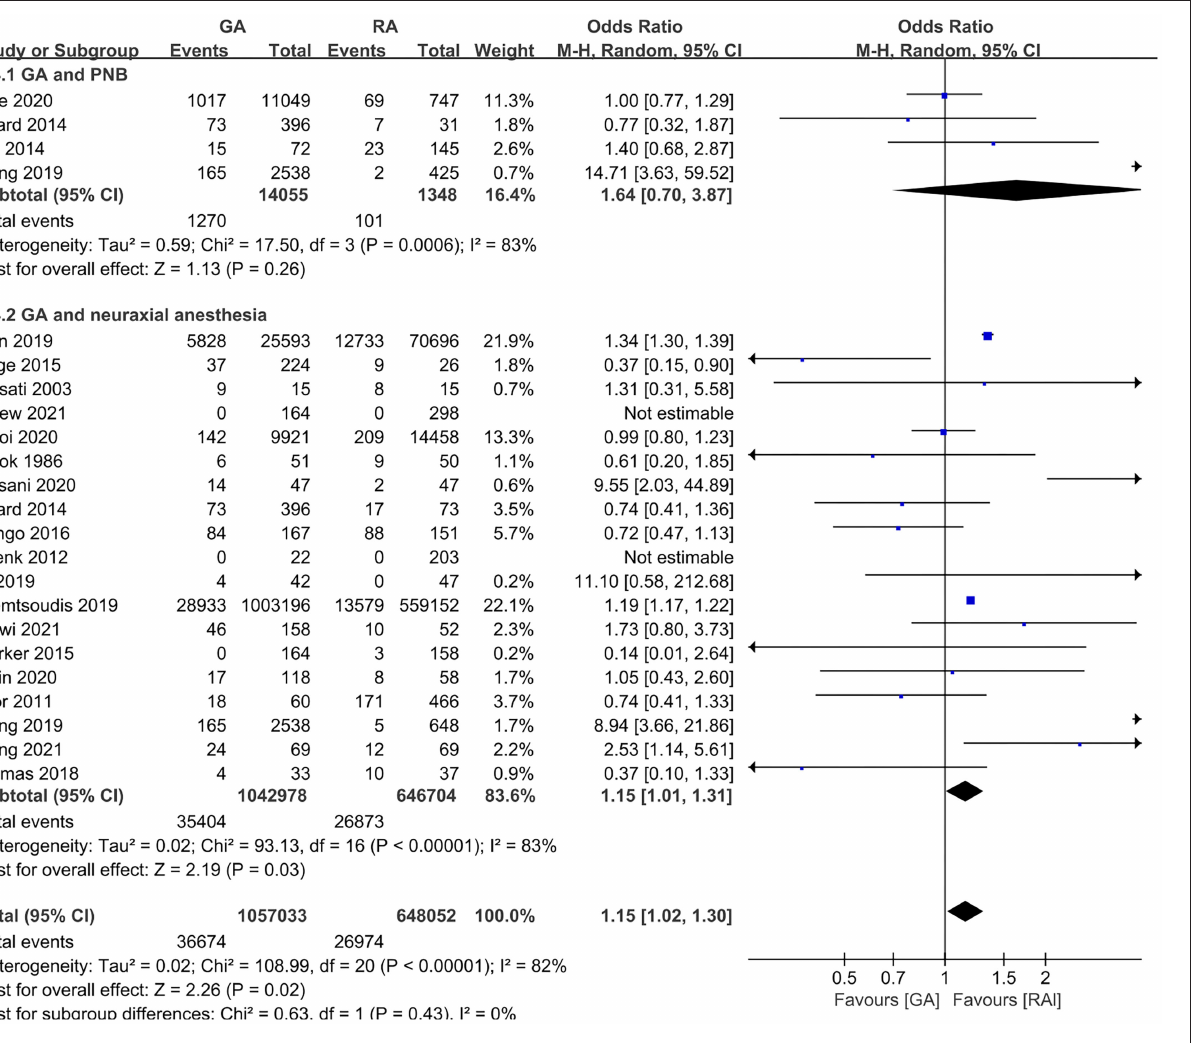
FIGURE 9 | The subgroup analysis according to anesthesia methods in the RA group (neuraxial anesthesia and